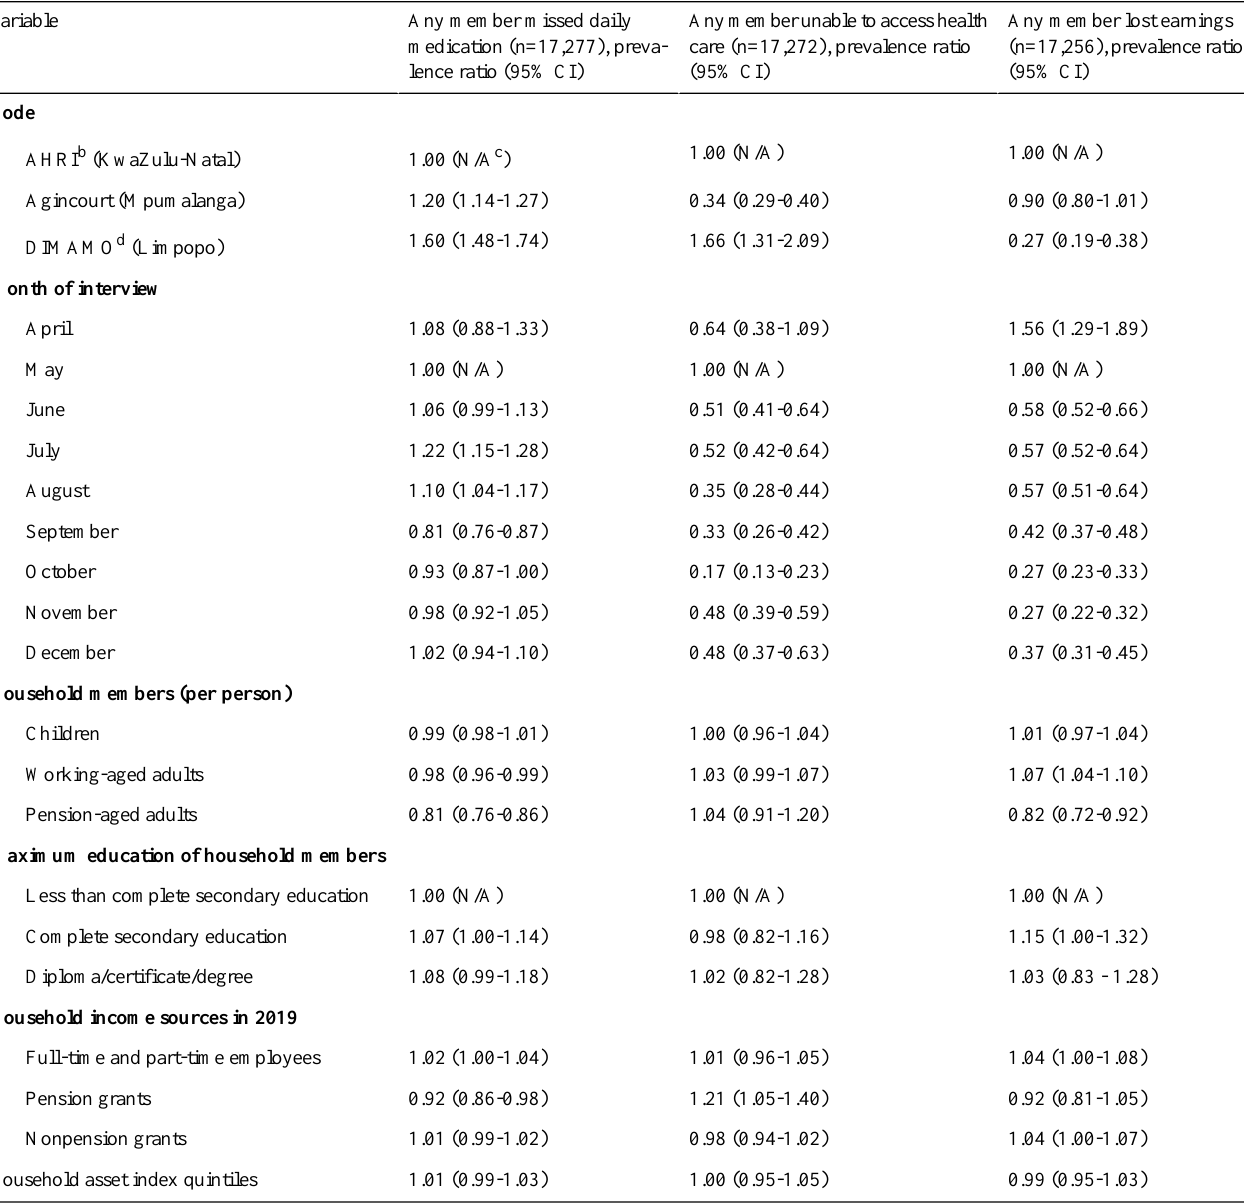
Table 4. Health care and economic behaviors at South African Population Research Infrastructure Network nodes from April to August 2020 a